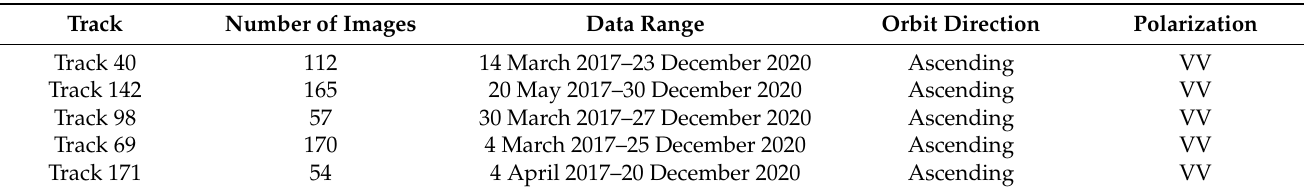
Figure 1. ( a ) The location of Shandong Province (SDP) and its coverage by Sentinel-1 images. ( b ) The location of SDP in China. Table 1. Detail parameters of the selected TerraSAR-X images.